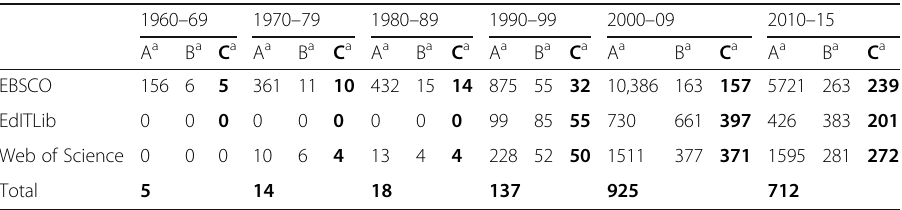
Table 1 Results of the search of